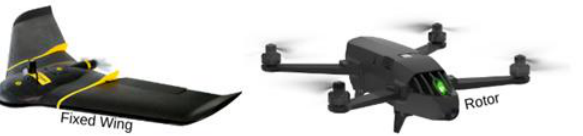
Figure 1. The fixed-wing eBee Sequoia (SQ) and the Parrot Anafi rotor drones from Parrot Group: picture concept adopted and modified from [1].